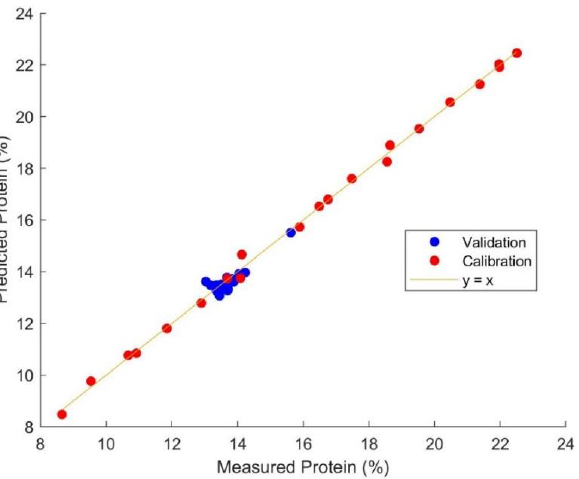
Figure 1. Prediction result of protein content of 20 local protein samples by a calibration model established with 21 global protein samples.